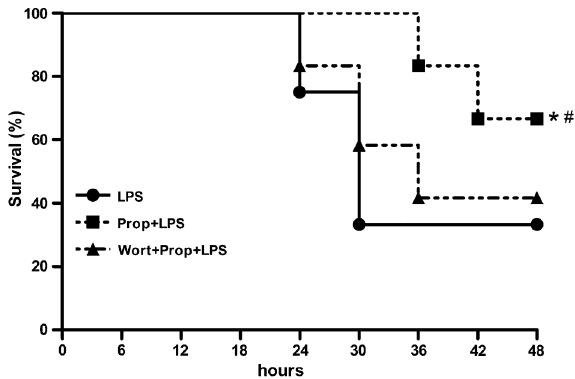
Figure 1. Survival curve of LPS-challenged rats combined with saline or propofol pretreatment. Data are reported as means±SD for n=12 animals per experimental group. LPS: lipopolysacchar- ide; Prop: propofol; Wort: wortmannin. *P , 0.05 compared to the LPS group; # P , 0.05 compared to the Wort++Prop++LPS group (log-rank test).